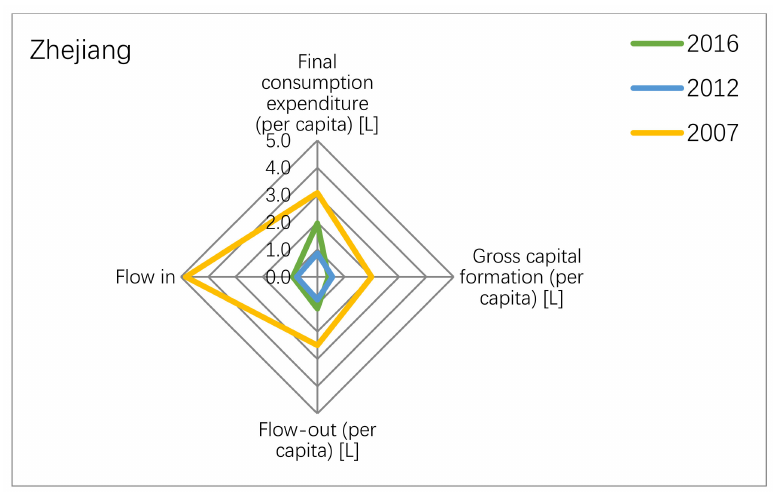
Figure 1. Four indicators changes of Zhejiang in 2007, 2012 and 2016 of group